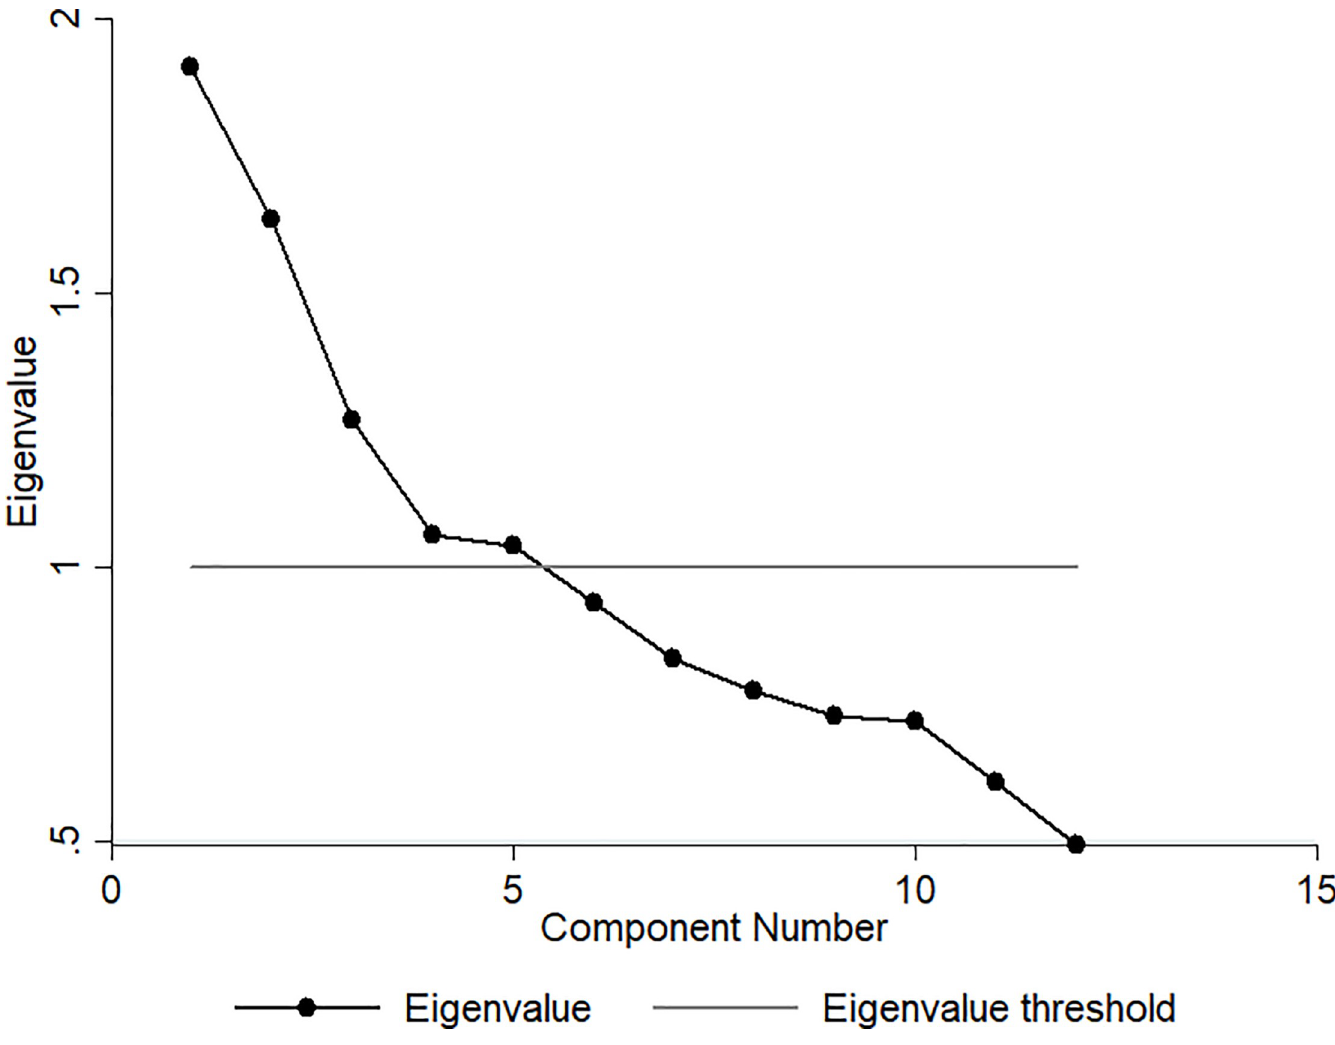
Fig 1. Cattell’s scree